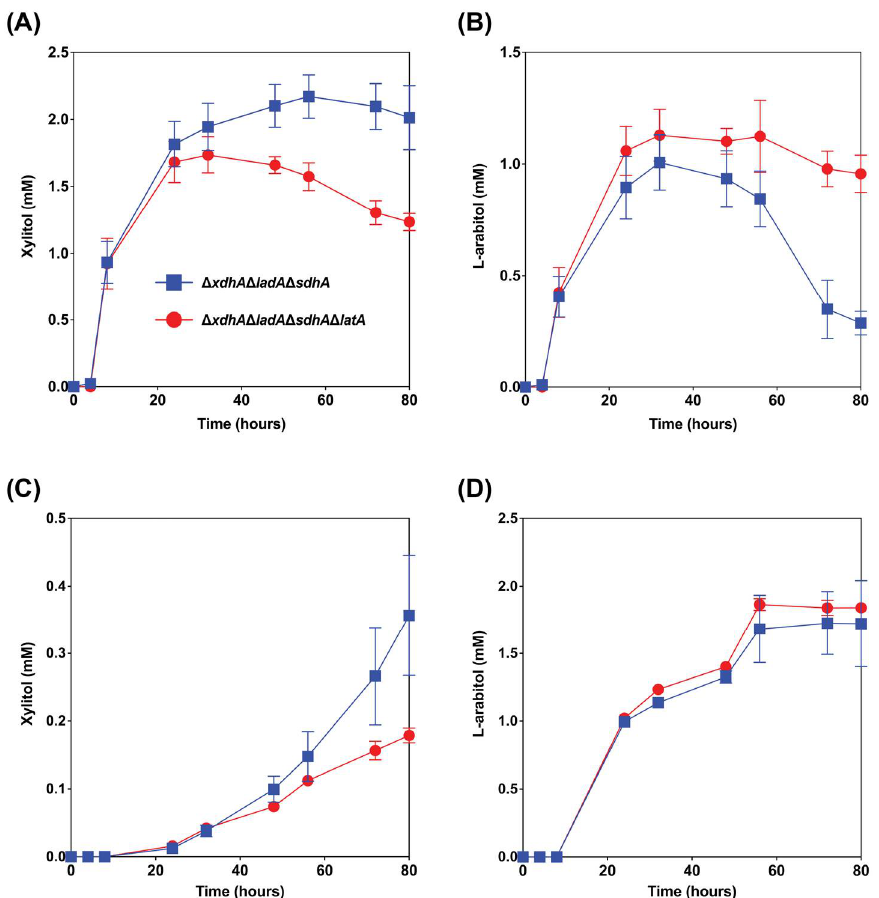
Figure 4. Extracellular xylitol and L -arabitol concentrations from wheat bran (( A ) and ( B ), respectively) and sugar beet pulp (( C ) and ( D ), respectively) cultures of the A. niger mutant strains Δ ladA Δ xdhA Δ sdhA and Δ ladA Δ xdhA Δ sdhA Δ latA . The error bars indicate the standard deviation between biological triplicates.